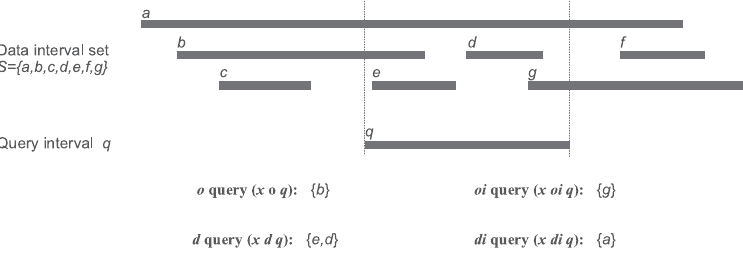
Figure 1. An example of interval queries regarding four different intersection relations, i.e., overlapping from the front ( o ), overlapping from behind ( oi ), contains ( di ) and contained in ( d ). The four types of interval queries are based on the query interval q and the data interval set